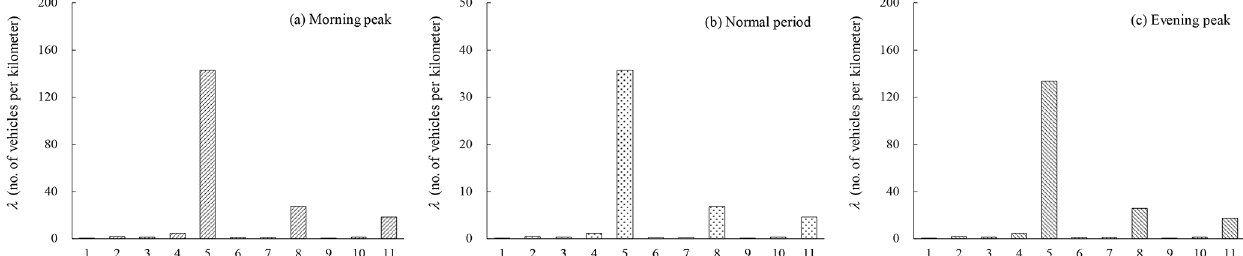
Figure 8. Mean rates of different types of vehicles during the (a) morning peak, (b) the normal period and (c) the evening peak. The numbers on the x axis refer to the following vehicle types: 1 – private buses, 2 – non-franchised public buses, 3 – franchised buses, 4 – taxis, 5 – private cars, 6 – public light buses, 7 – private light buses, 8 – goods vehicles, 9 – special-purpose vehicles, 10 – government vehicles, and 11 – motor cycles.